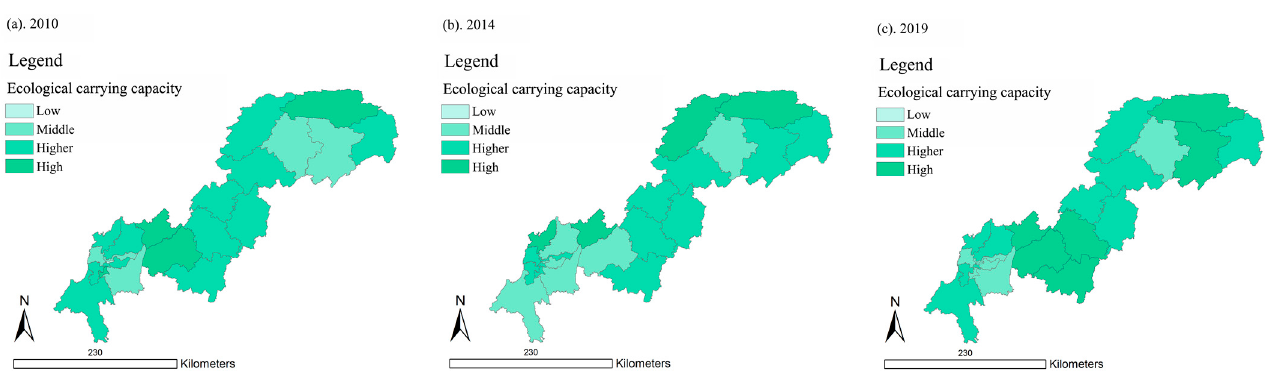
Figure 7. Spatial distribution of ECC in the Three Gorges Reservoir Area (Chongqing section) in year 2010, 2014, and 2019 (presented in subfigure a – c , respectively). Sources: Calculation results of ECC in the Three Gorges Reservoir Area (Chongqing section).